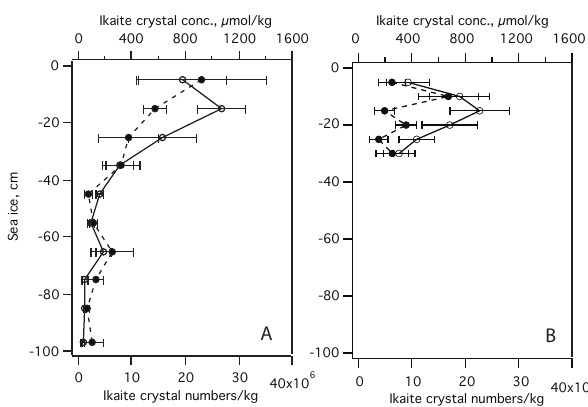
Fig. 6. Vertical distribution of ikaite crystals determined from image analysis. Abundance of crystals (-o-) and concentration of ikaite (- - • - -) at ICE I (A) and POLY I (B)